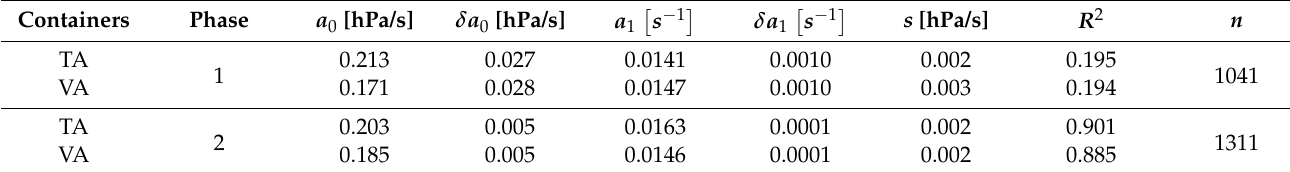
Table A2. Fit parameters for the linear model α ( ∆ e (cid:48) w ) according to Equation (22) for Experiment 1, fitted to the measurements made in the various containers and experimental phases ( δ —standard error, s —standard deviation of residuals, R 2 —squared correlation coefficient, n —number of data).